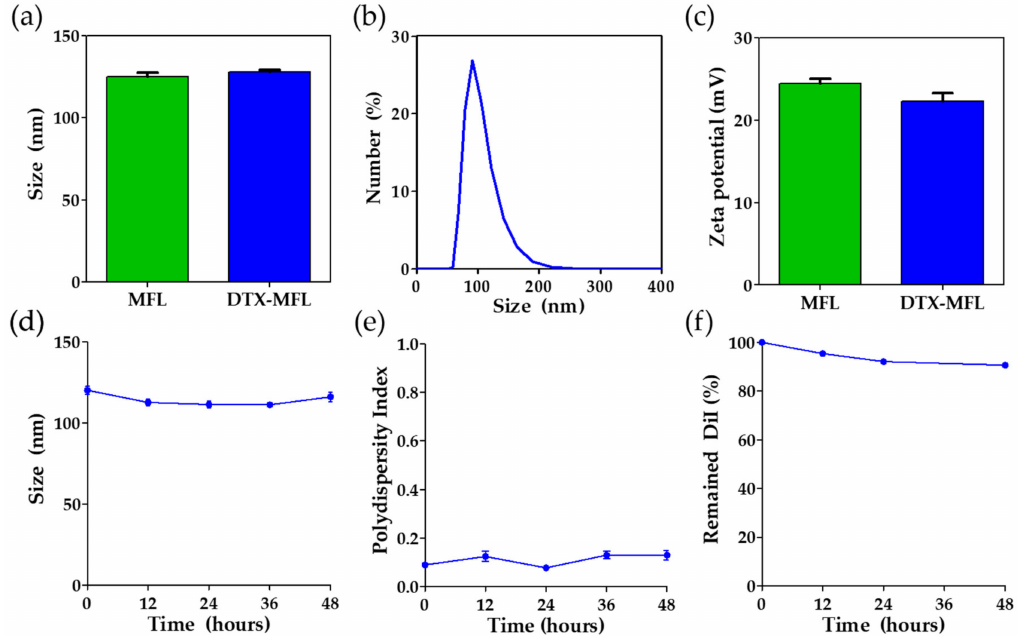
Figure 2. ( a ) Hydrodynamic sizes of MFLs and docetaxel-loaded (DTX)-MFLs as measured by dynamic light scattering (n = 4). ( b ) Distribution of hydrodynamic sizes of DTX-MFLs (n = 4). ( c ) Zeta potential of MFLs and DTX-MFLs (n = 6). ( d ) Particle size stability of DTX-MFLs up to 48 h. ( e ) Particle polydispersity index of DTX-MFLs up to 48 h. ( f ) Normalized fluorescence of remaining 1,1 (cid:48) -dioctadecyl-3,3,3 (cid:48) ,3 (cid:48) -tetramethylindocarbocyanine perchlorate (DiI) in DiI-loaded MFLs up to 48 h. MFL and DTX-MFL denote membrane fusogenic liposomes and docetaxel-loaded membrane fusogenic liposomes. Data represent averages ±